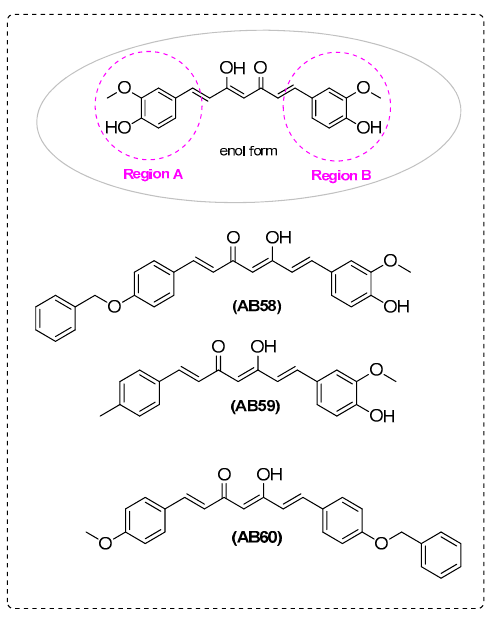
Figure 9. inhibitors. Figure 9. Antioxidant